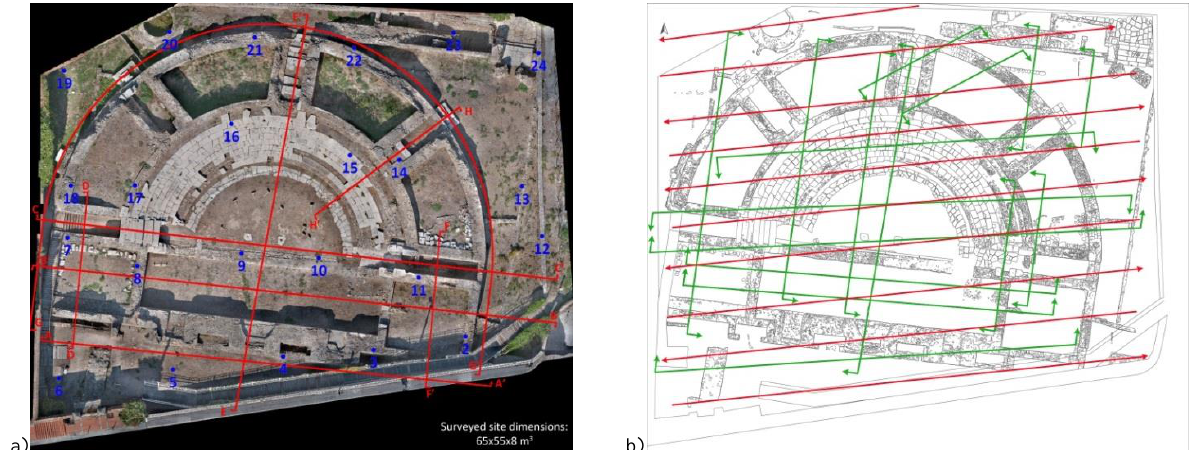
b) Figure 1. a) Orthoimage of the Roman theatre in Ventimiglia, Italy. The red lines represent the required cross sections and orthographic views. The blue dots are the points measured with the total station and afterwards used as GCPs and CPs for